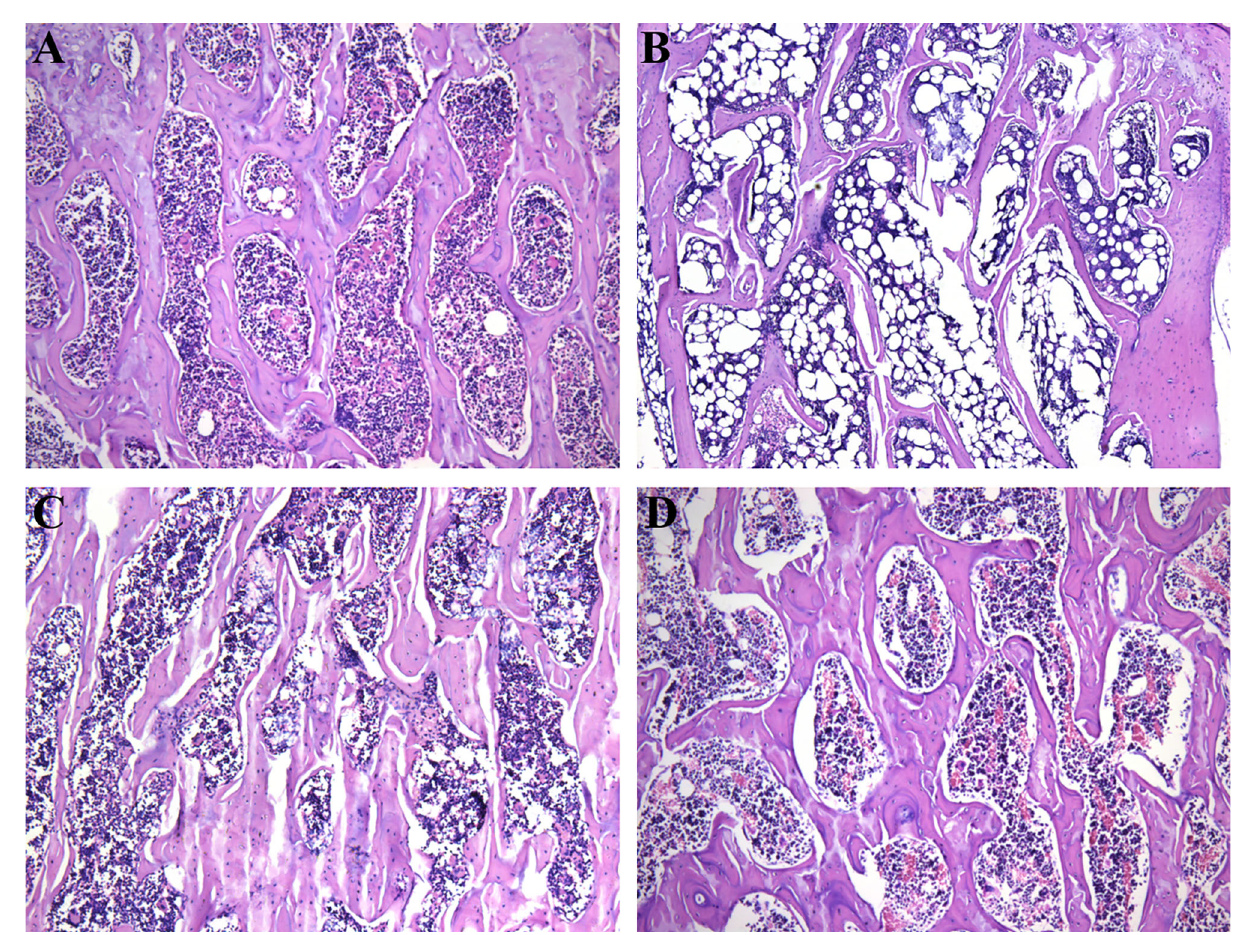
FIGURE 2 | Therapeutic effects of different treatments on the bone trabecular structure (100 ×) of PMOP model. (A-D) represent the HE images of Sham, OVX, OVX+ICA and OVX+E2 groups,